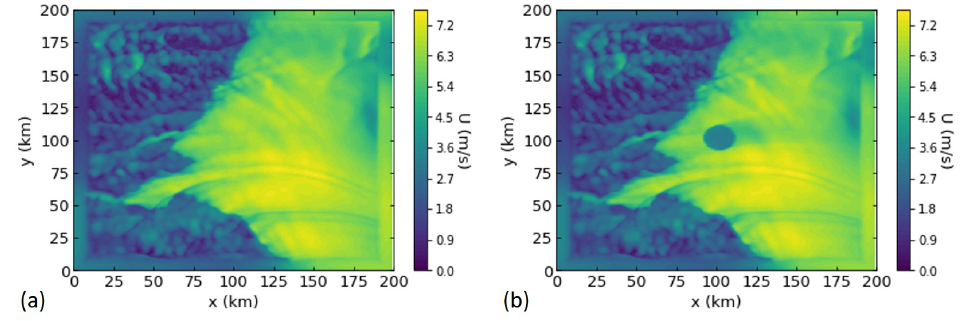
Figure 2. Examples of contour maps of the wind speed at the lowest model level, obtained from “twin” simulations: ( a ) without farm; ( b ) with